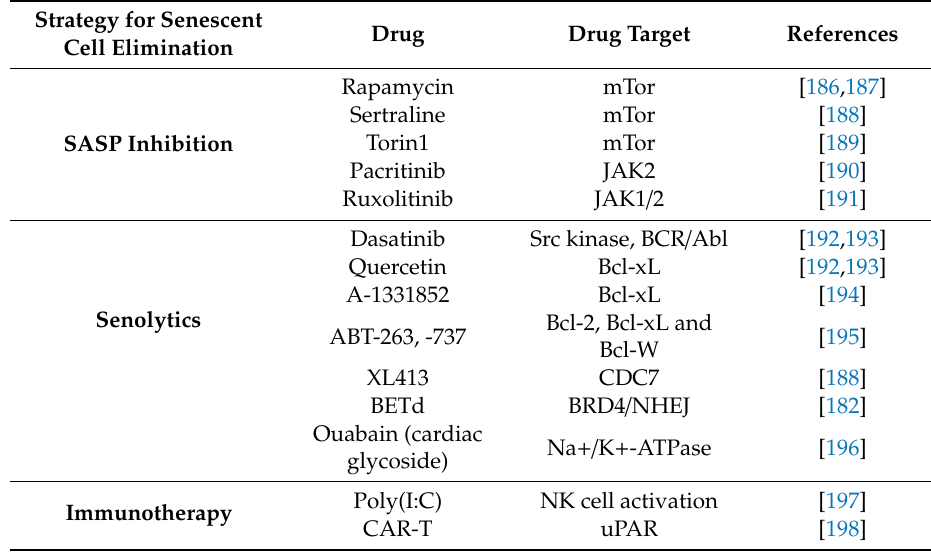
Table 2. Drugs targeting senescence in